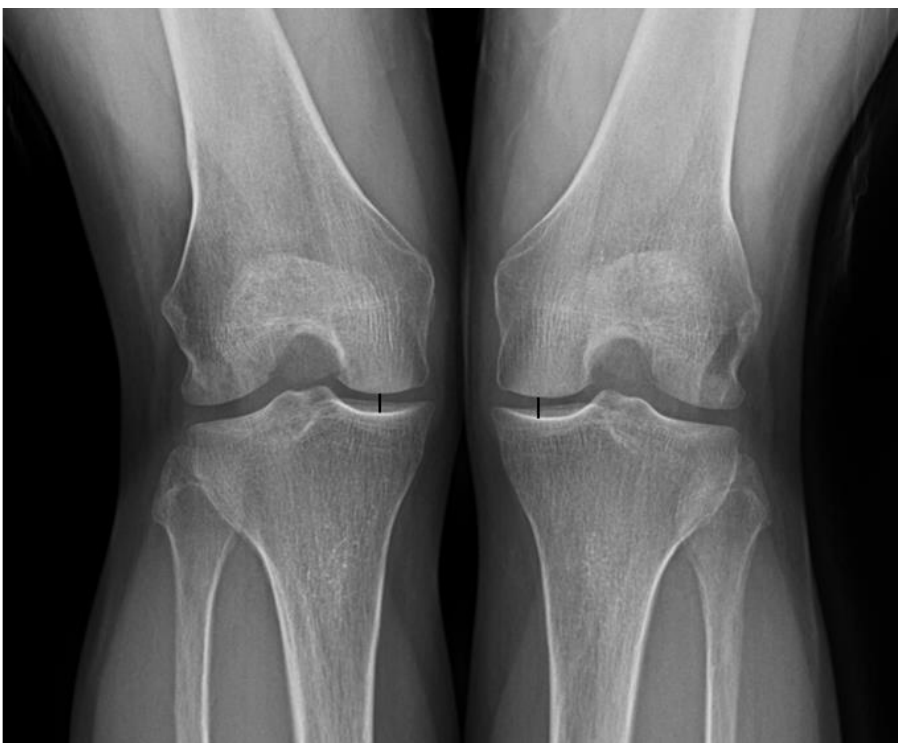
Figure 3. The height of joint space in the medial compartment of the tibiofemoral joint was measured with weight-bearing posteroanterior view taken at 45° of flexion. The distance between the center of the medial femoral condyle and the center of the medial tibial plateau were measured bilaterally (black line).